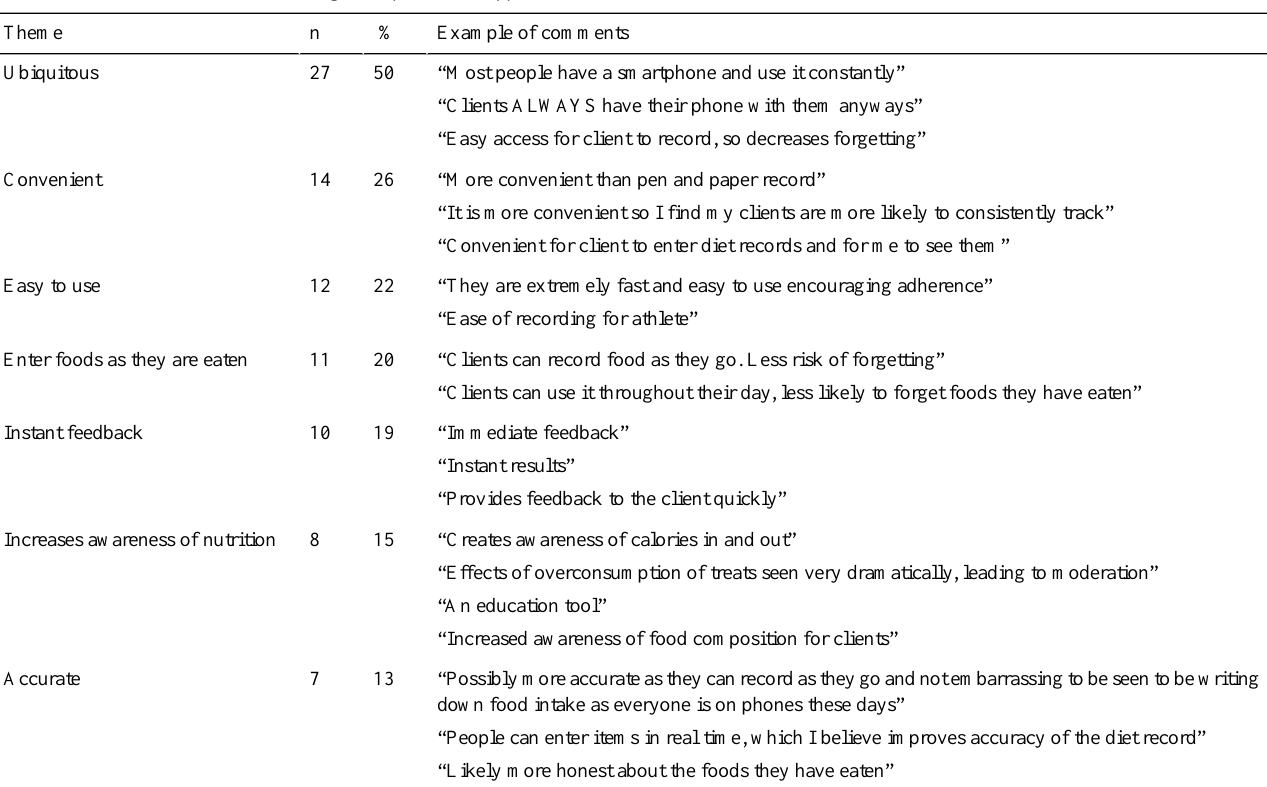
Table 3. “What are the benefits of using smartphone diet apps?” (N=54) b